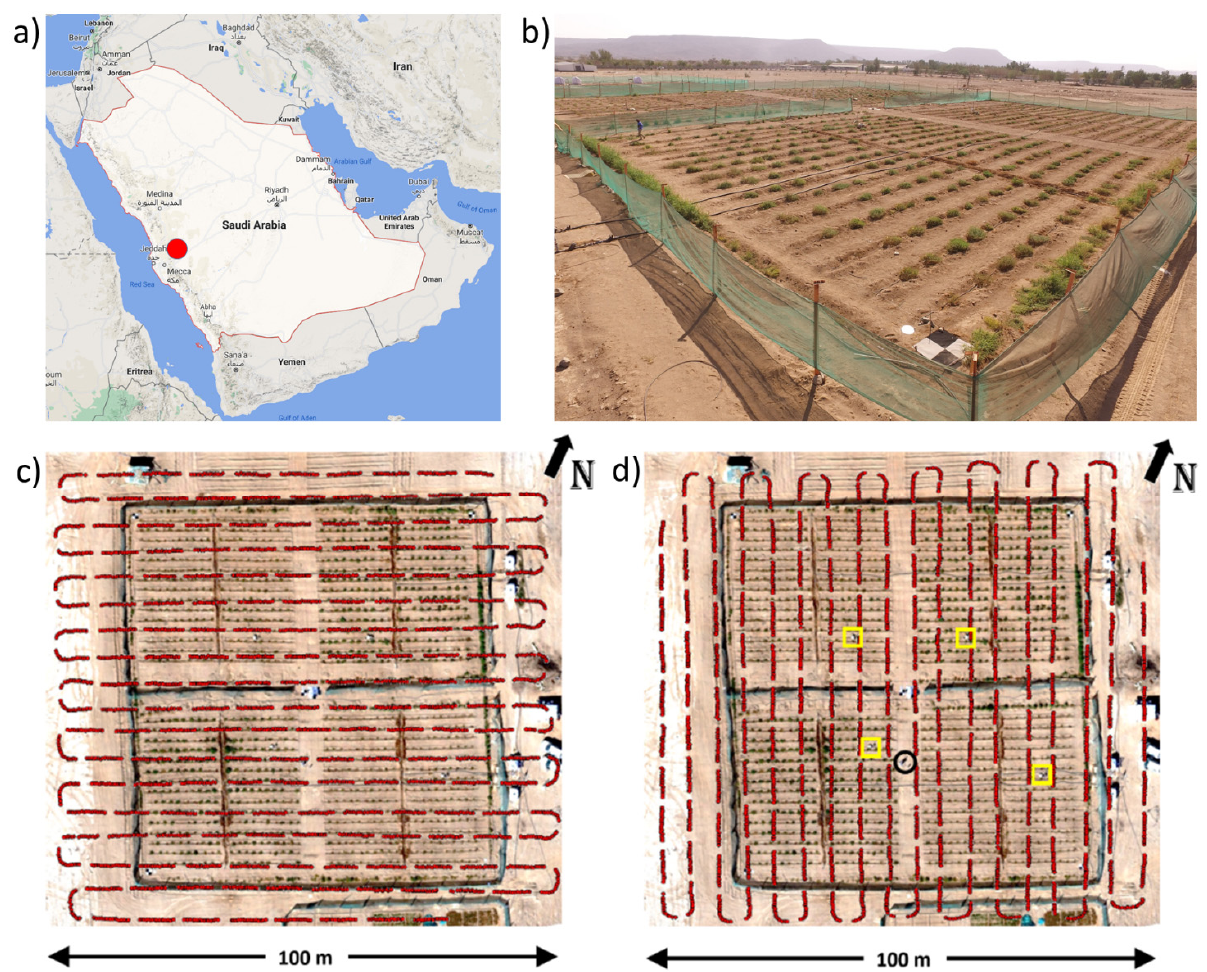
Figure 1. ( a ) Study site location (red dot) in Saudi Arabia of the tomato experiment ( b ) at the Hada Al-Sham agricultural research station, approximately 60 km east of Jeddah. Layouts of the experimental tomato plant trial with an overlay of flight directions at 66°/246° ( c ) and 156°/336° ( d ) north are also shown. The yellow squares show the location of four installed Apogee sensors and the black circle indicates the location of a weather station ( d ).